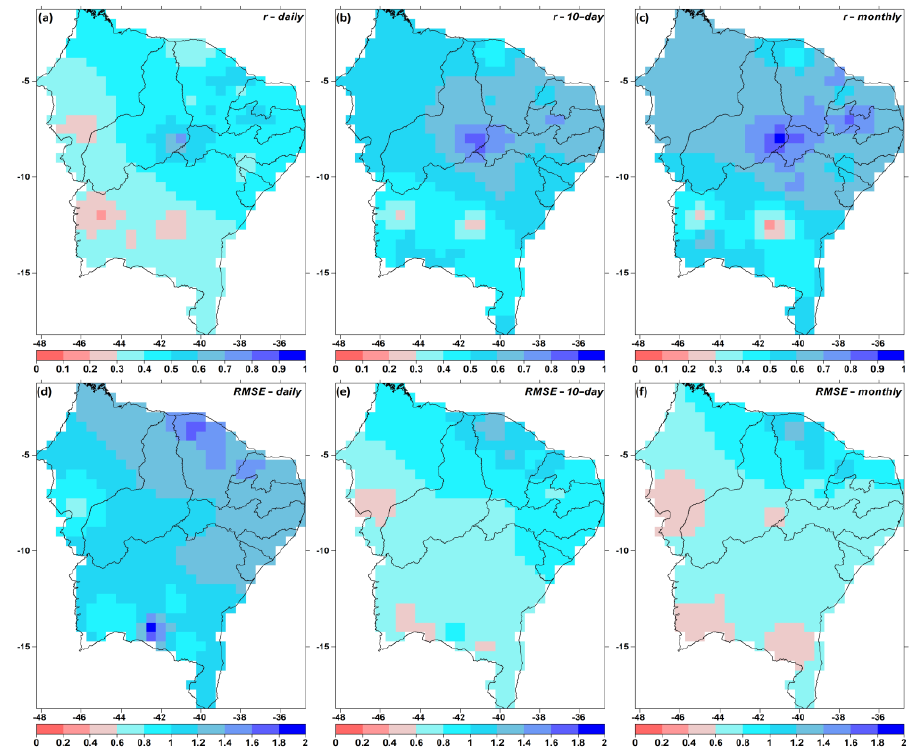
Figure 8. Correlation maps for wind speed between imputed and observed data on the daily ( a ), 10-day ( b ) and monthly ( c ) timescales; and RMSE (m/s) on the daily ( d ), 10-day ( e ) and monthly ( f ) time-scales.